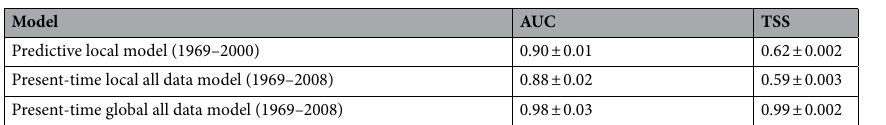
Table 2. Internal evaluation statistics for the generated species distribution models (SDMs) generated. AUC and TSS values are average values ± standard deviation for the algorithms used in the SDMs.